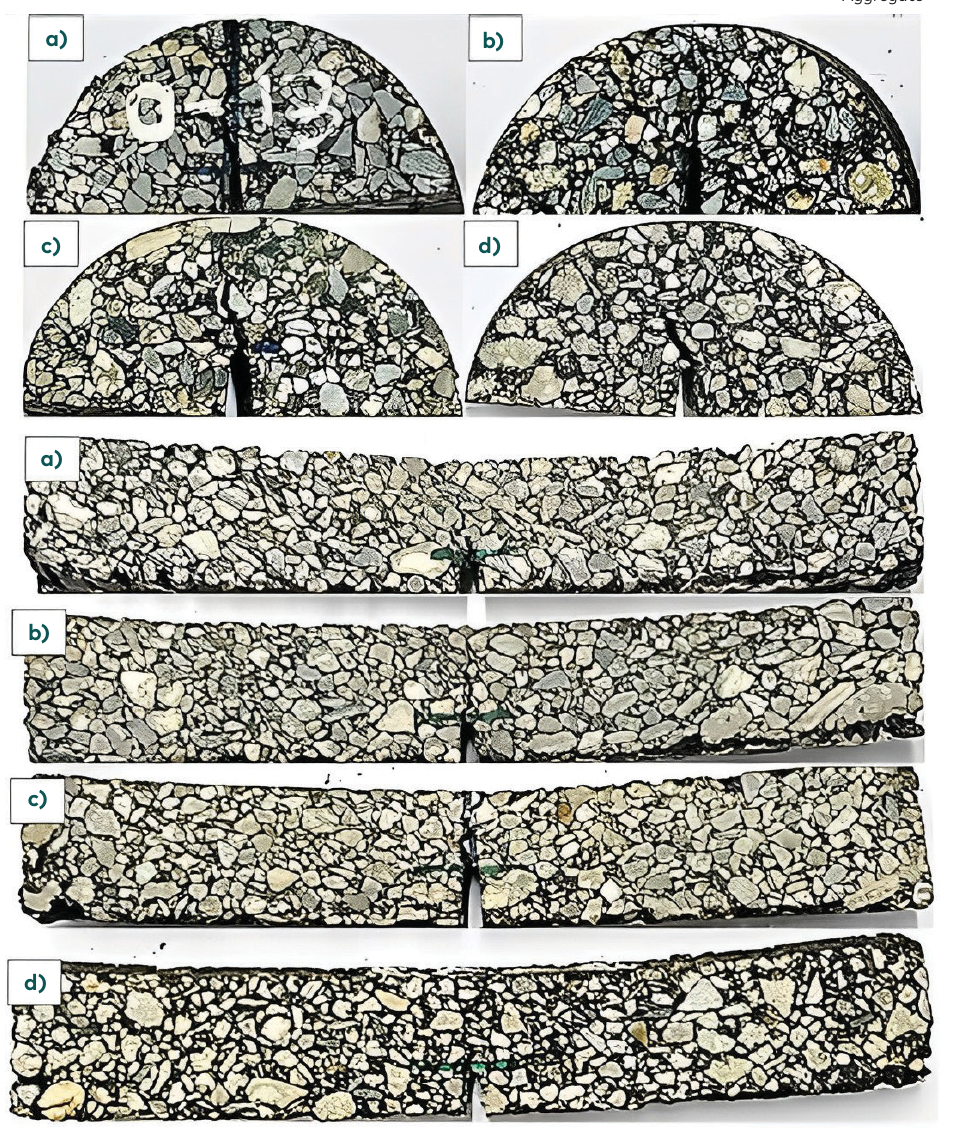
Figure 7. Cracks in SCB and SENB samples (a) SMA-0; (b)